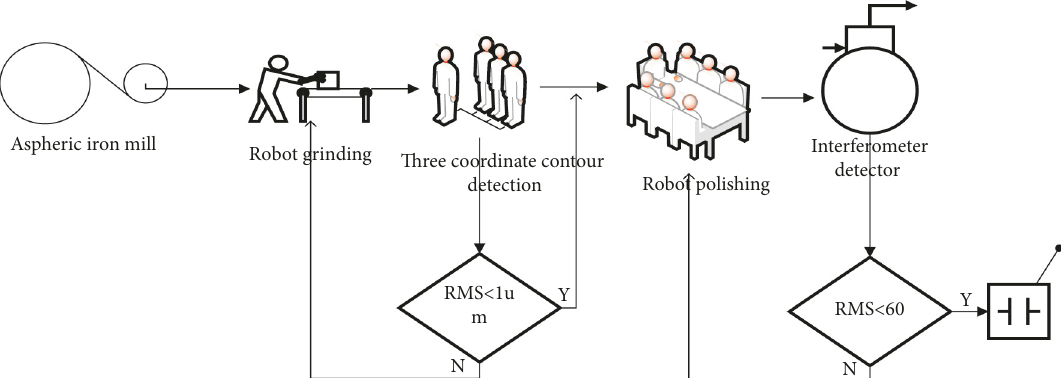
Figure 5: Processing flowchart of the aspheric mirror.